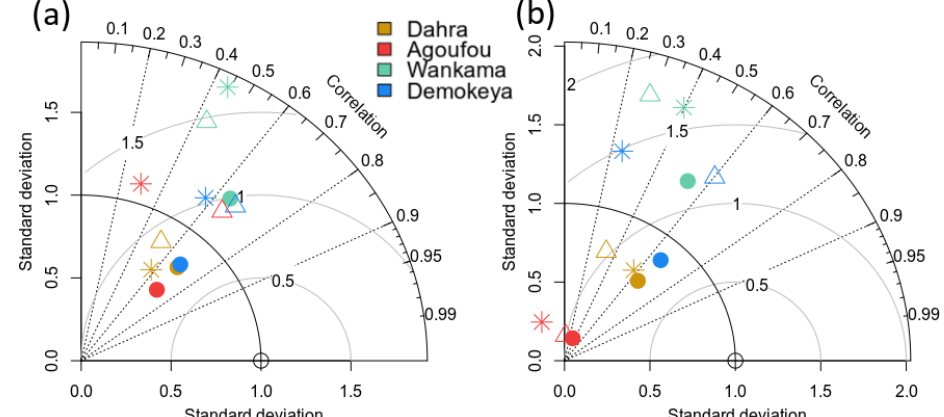
Figure 6. Taylor diagrams showing the correspondence between modelled and observed daily NEP values (10d moving averages) for the Sahel flux tower sites, evaluated over (a) the whole year and (b) the rainy season only. We show a comparison between runs based on published model parameters using CRU–NCEP meteorological data ( ∗ ), published model version parameters using WFDEI–MSWEP drivers ( (cid:52) ) and runs based on the new drylands-specific parameterization using the WFDEI–MSWEP drivers ( • ). Values were normalized so that the standard deviations of the observations equal unity; i.e. observations are located at the (1, 0) coordinate on this figure. Grey arcs represent the root mean square error (RMSE) between model output and